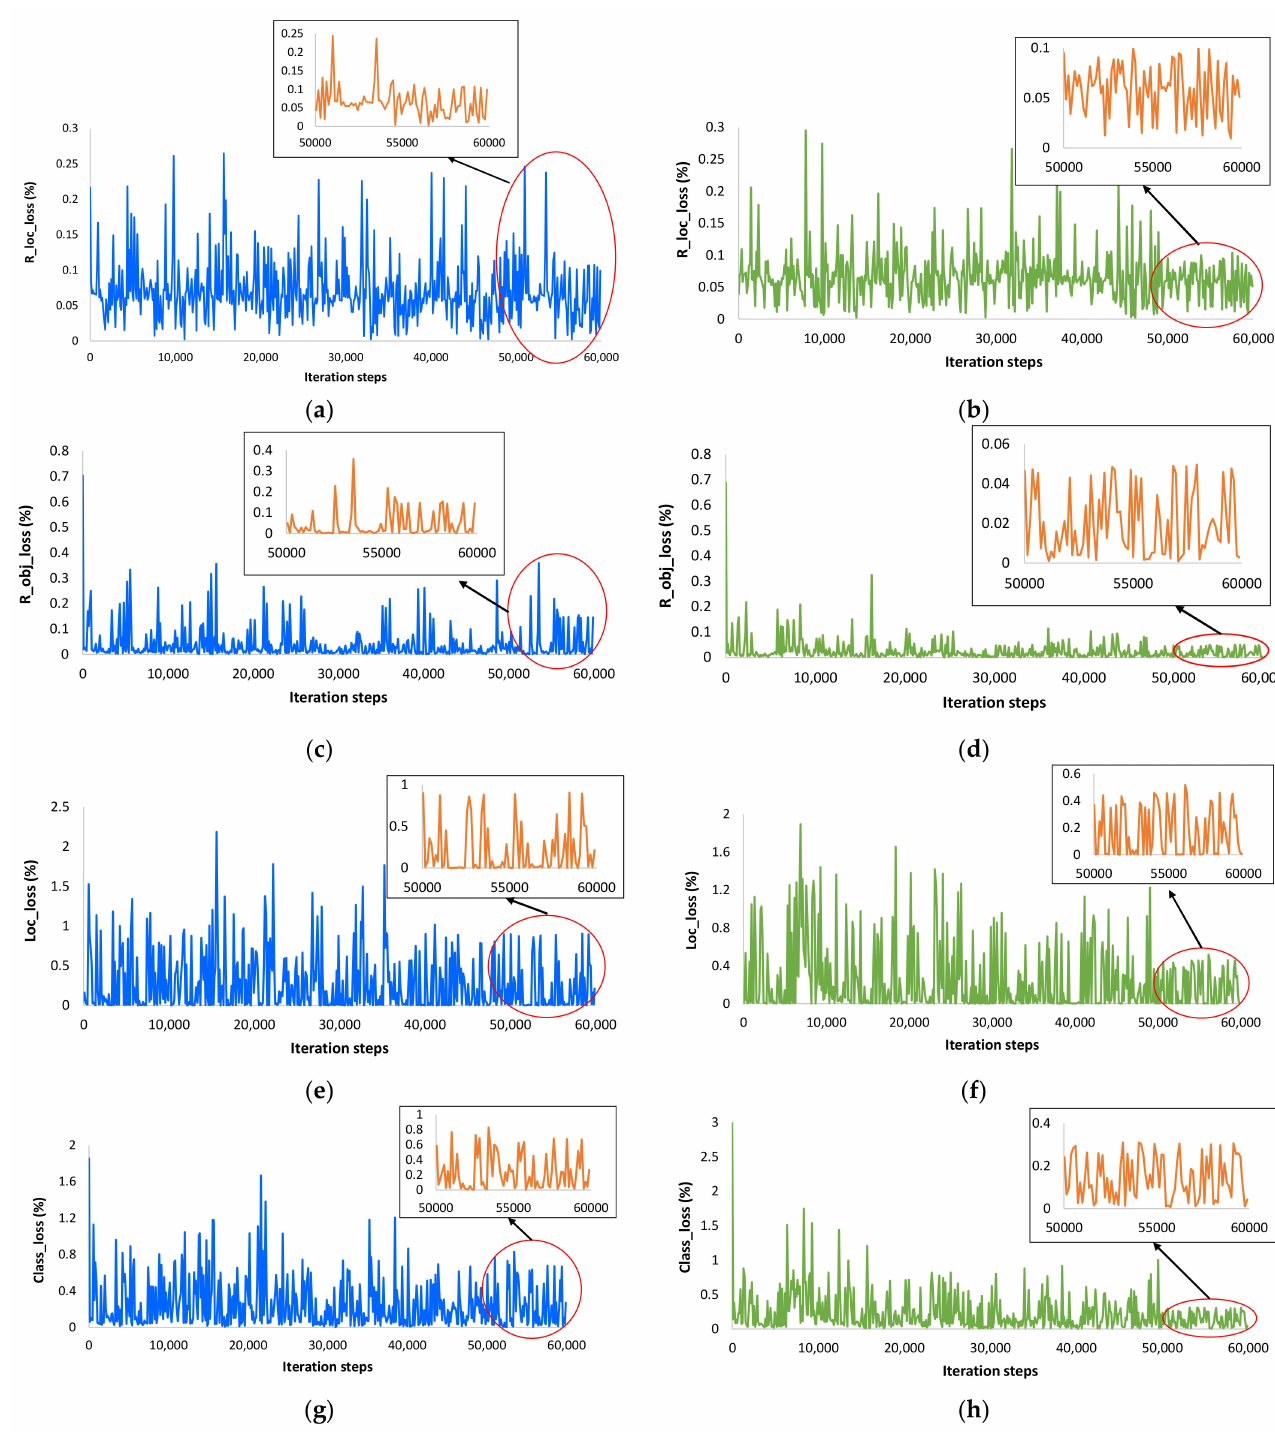
Figure 6. Training loss plots of the Faster RCNN model: ( a ) RPN localization loss with default settings; ( b ) RPN localization loss after adding 64 × 64-scale-size window; ( c ) RPN objectness loss with default settings; ( d ) RPN objectness loss after adding 64 × 64-scale-size window; ( e ) box classifier localization loss with default settings; ( f ) box classifier localization loss after adding 64 × 64-scale-size window; ( g ) box classifier classification loss with default settings; ( h ) box classifier classification loss after adding 64 × 64-scale-size